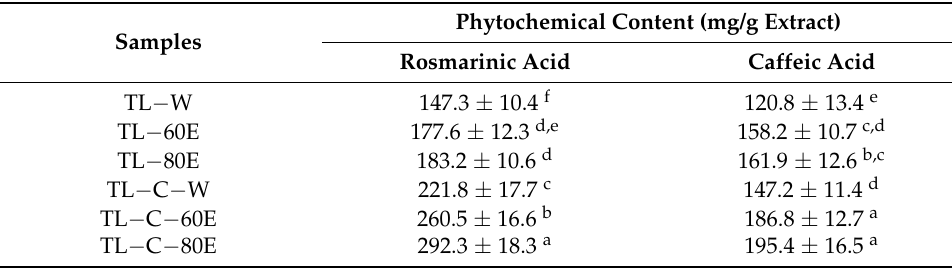
Table 2. Rosmarinic acid and caffeic acid contents in T. laurifolia